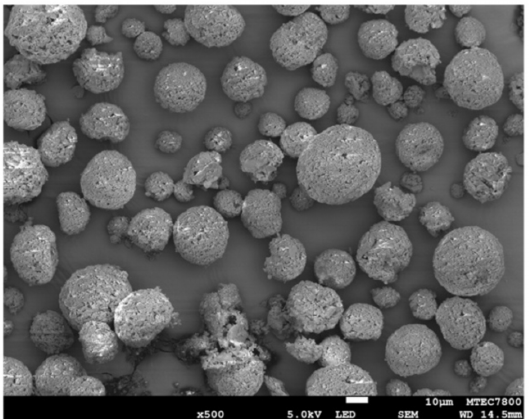
Figure 3. SEM image of spherical pre-reacted glass fillers (SPG) after the spray drying process. Reproduced with permission under a Creative Common Attribution License from Panpisut et al. (2020). Reprinted with permission from